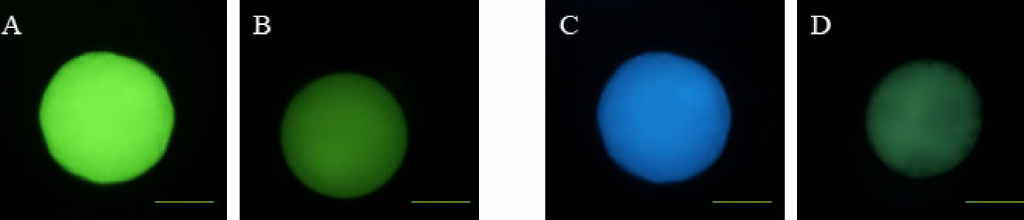
Figure 3. Representative images of reactive oxygen species (ROS) and glutathione (GSH) levels in sheep oocytes. ( A ) High ROS intensity; ( B ) low ROS intensity; ( C ) high GSH intensity; ( D ) low GSH intensity. Scale bar = 51 µ